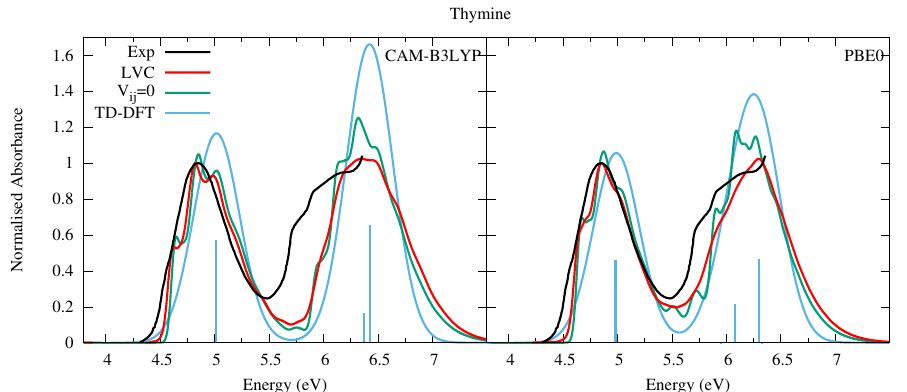
Figure 3. Absorption spectra of Thymine from the LVC model (red), without inter-state coupling (green), TD-DFT calculations with stick spectra (blue), and experimental data of 1-methylthymine (black) [52]. Low energy peak from experiment and LVC spectra normalised to 1, with other calculated spectra normalised with the same value as LVC spectra. CAM-B3LYP spectra red-shifted by 0.3 eV, PBE0 by 0.15 eV. LVC spectra broadened with Gaussian HWHM 0.04 eV, TD-DFT with HWHM 0.25